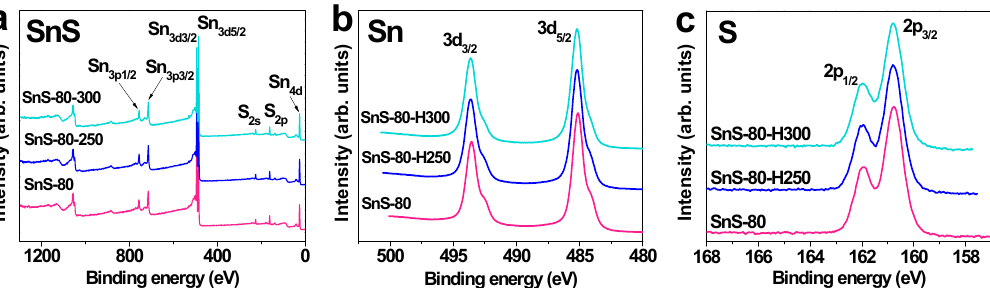
Figure 5. Survey ( a ) and high-resolution (( b ) Sn 3d and ( c ) S 2p) XPS profiles of SnS-80, SnS-80-H250, and SnS-80-H300.